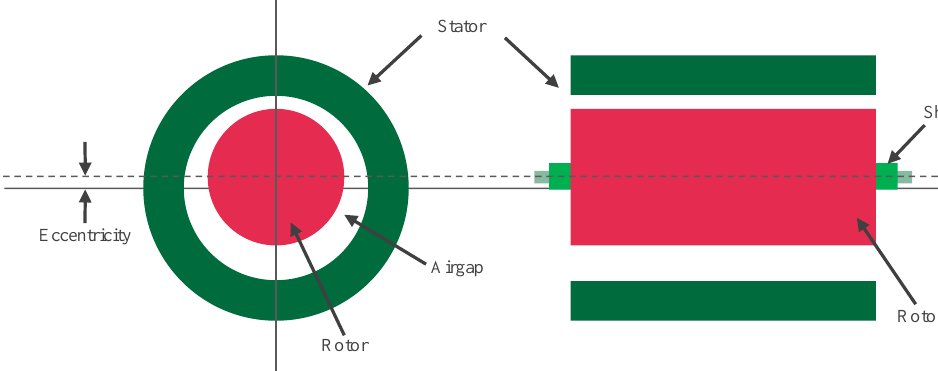
Figure 16. Airgap deformation due to eccentricity [123].